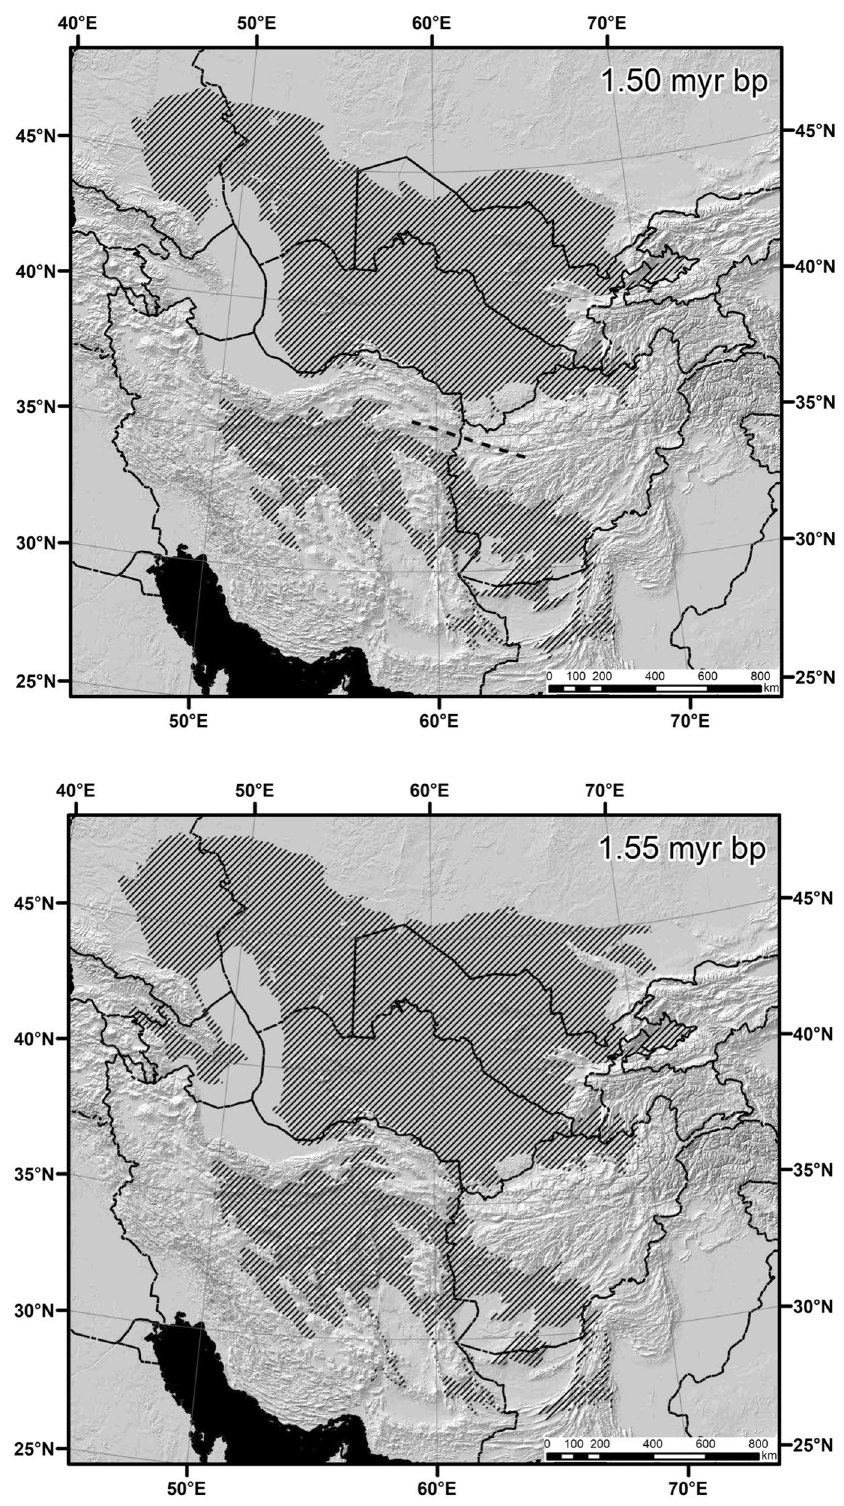
Figure 5. Geography of speciation in the node no. 13: divergence between Scarturus elater and S. indicus groups. Variables used in the modeling: Bio 3, Bio 7, Bio 9, Bio 10, Bio 11, Bio 12, and Bio 19. AUC = 0.875. Threshold value = 0.301. The maps were obtained as raster maps from modeling using MAXENT 3.4.1 software and then generated as polygon maps using ArcGIS Desktop 10.8.1 software. MAXENT: available at https:// biodi versi tyinf ormat ics. amnh. org/ open_ source/ maxent/. ArcGIS Desktop: Copyright © 1995–2020